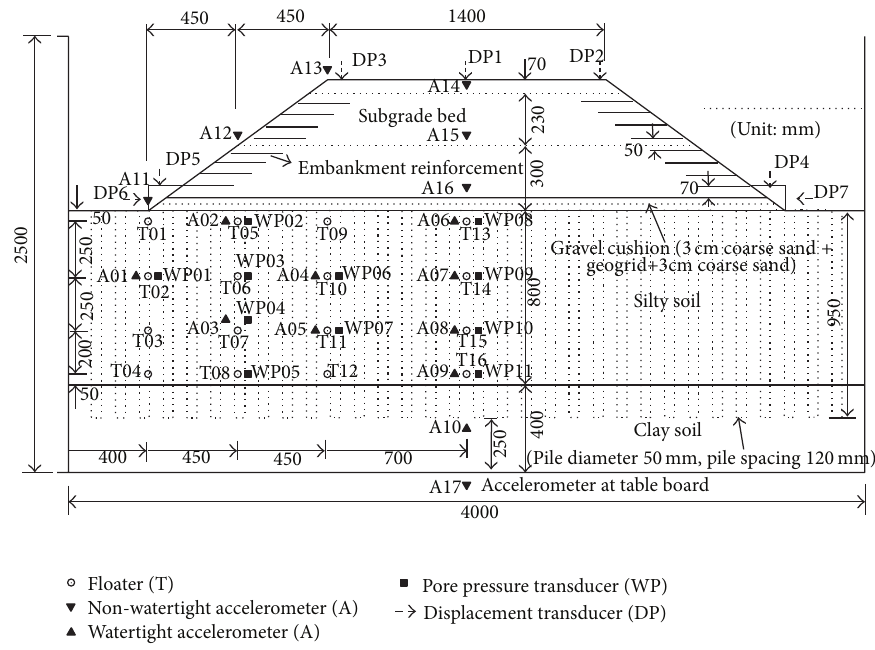
Figure 3: Model and arrangement of instruments (unit:mm).